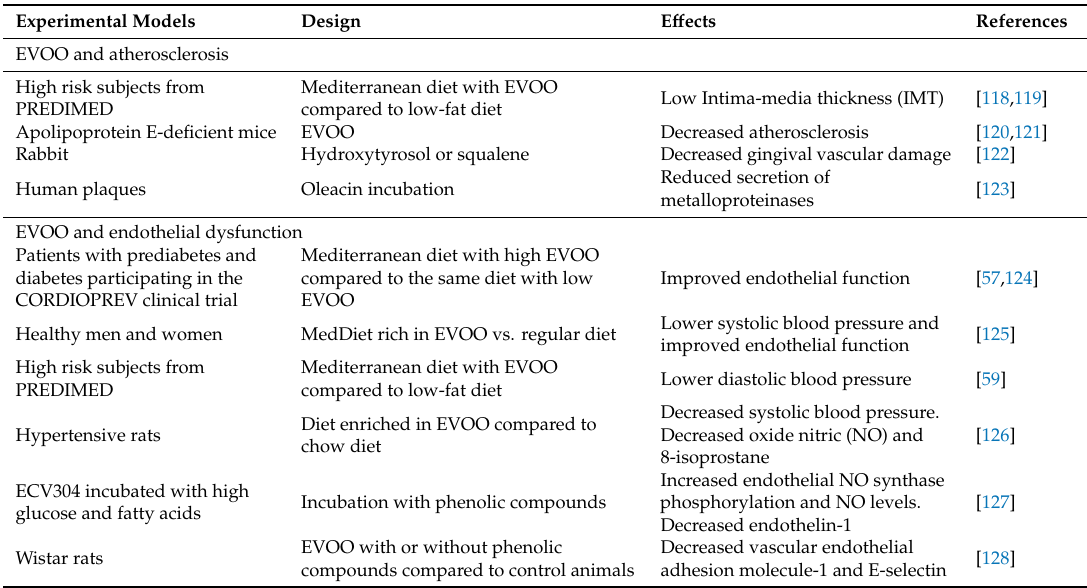
Table 1. Overview of extra virgin olive oil (EVOO) and molecular and cellular mechanisms participating in the origin and progression of cardiovascular